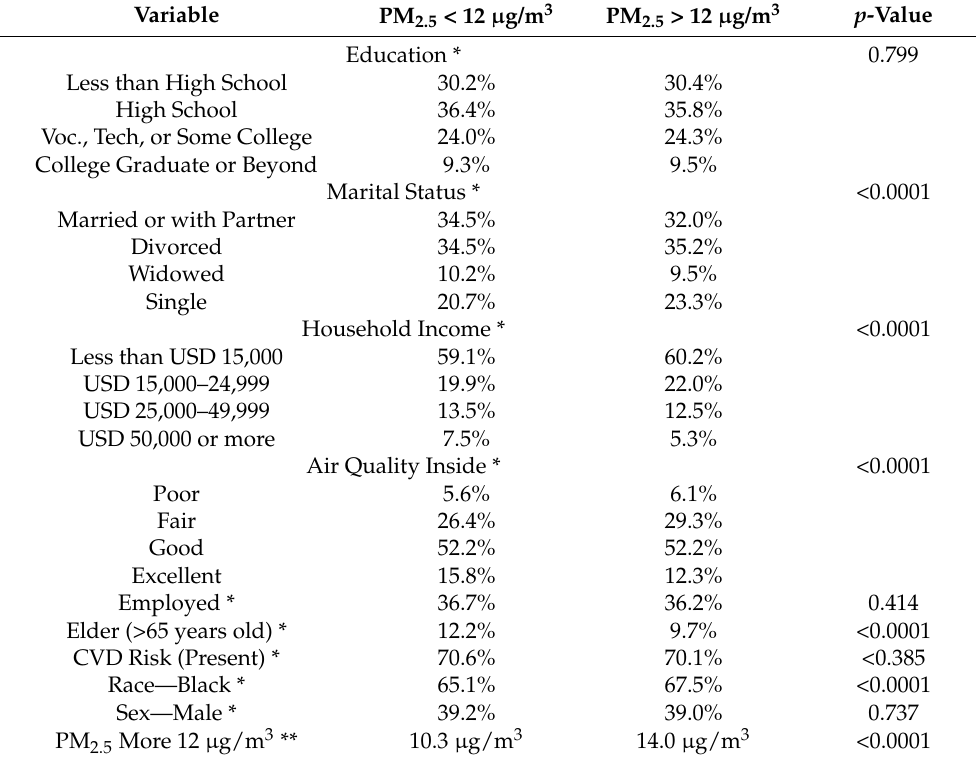
Table 2. Percentage of Participants by Social Characteristic Living in Low and High PM 2.5 Exposure Locations in 12 Southeastern United